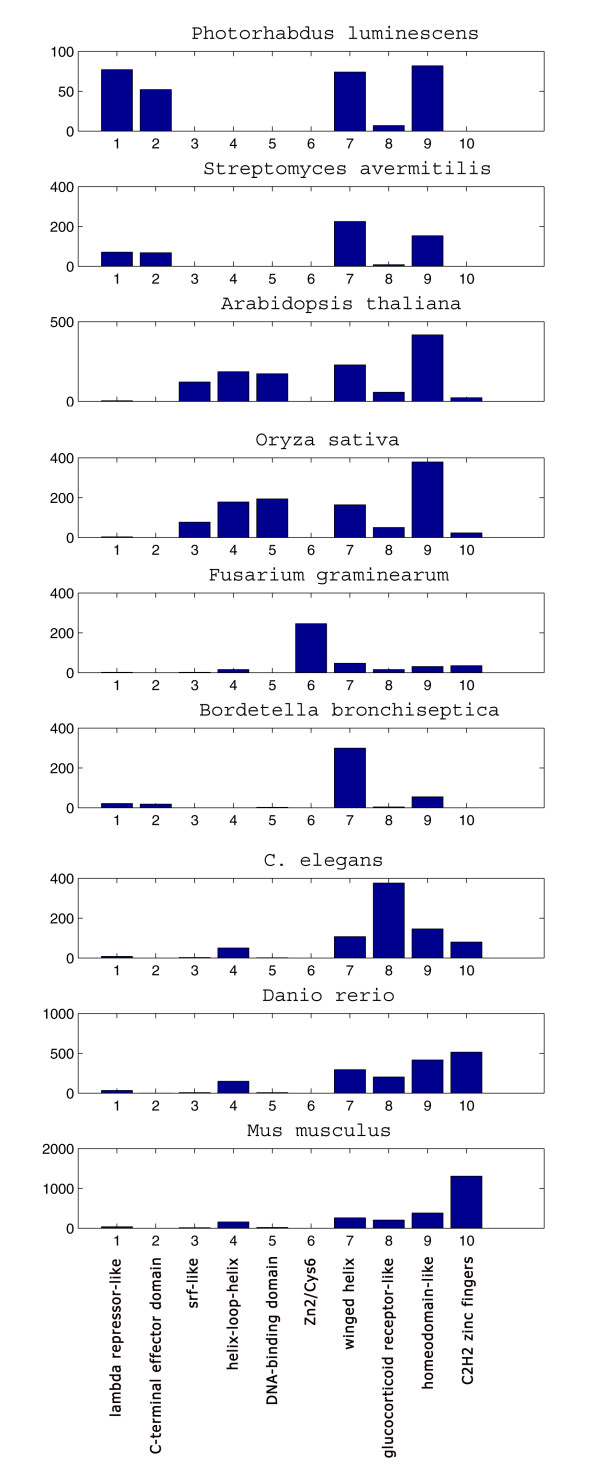
Distribution of transcription factors for the 9 organisms in Table 1 among the different super-families. On the x axis are the 10 super-families of table 1, on the y axis their counts in each organism. The organisms are sorted according to increasing number of genes in the genome.  Note that the y-axis scale is different for different organisms.